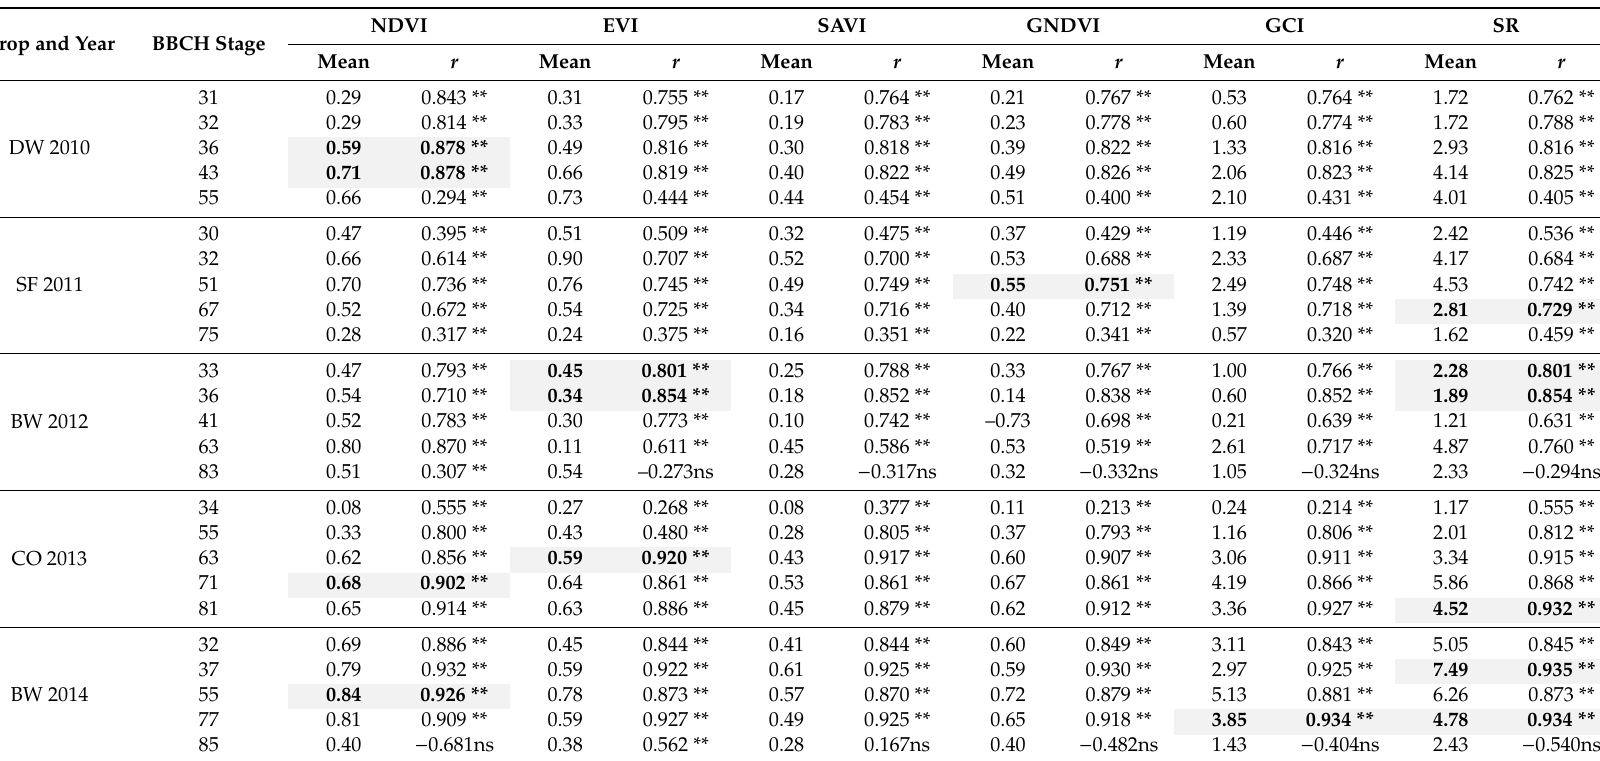
Table 5. Mean value of remote vegetation indices and Pearson’s correlations (r) with crop yields in the five years. VIs with best correlations with GY are highlighted. Crop and